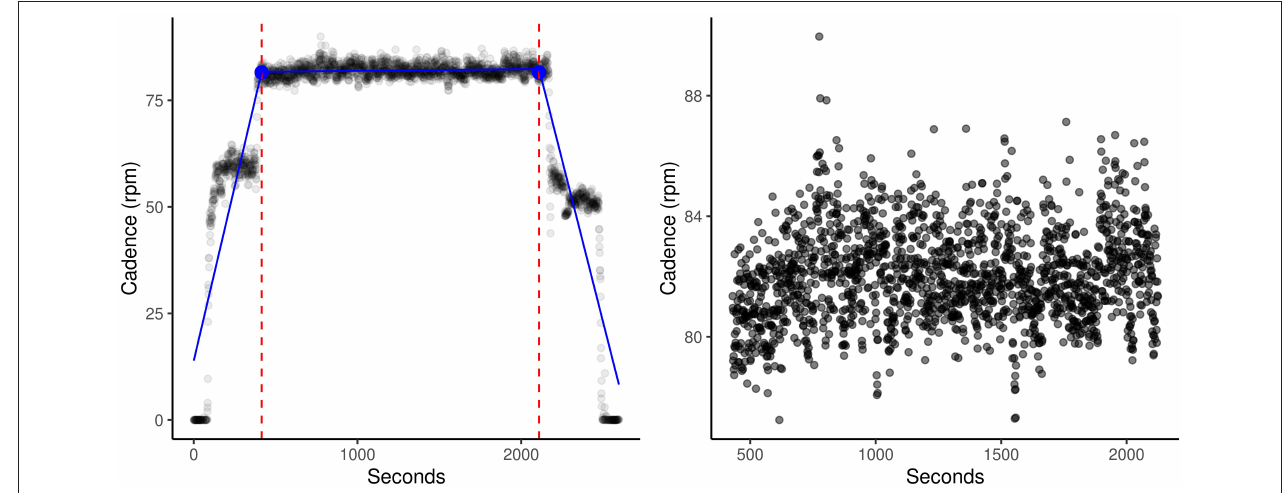
FIGURE 1 | SMB005_day2 (Before) and SMB005_day2 (After). Demonstration of one typical session on the dynamic bike. Dashed lines and blue dot indicate the estimated break points. Blue lines indicate the three calculated regression lines. Using our segment_cutter.r script and the segmented R library, warmups and cooldowns were automatically and objectively cut from the main session. This allowed for more accurate calculations of entropy and effort.